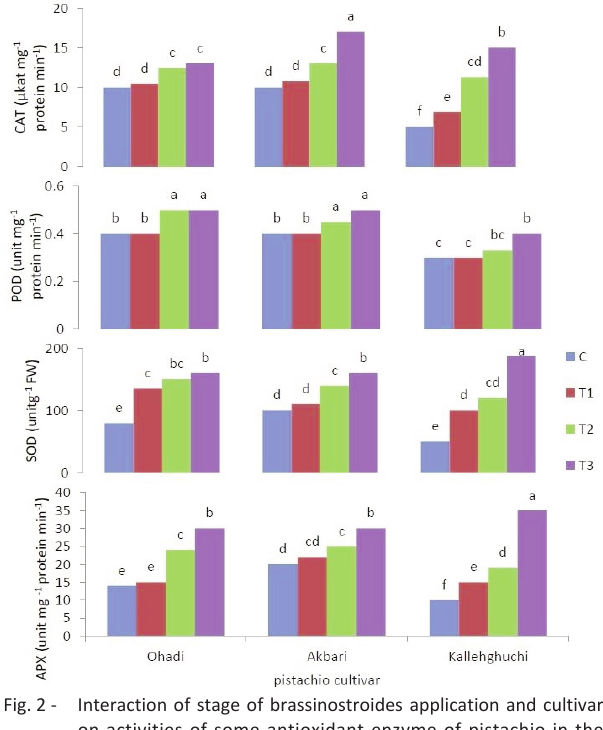
Fig. 4 - Interaction of stage of brassinostroides application and cultivar on annual changes in total non-structural carbohydrate (TCN) concentration of one-year-old wood of pistachio in the “off” year. C= Control, T1= Bud swelling phase, T2= two weeks after full bloom, T3= T1 and